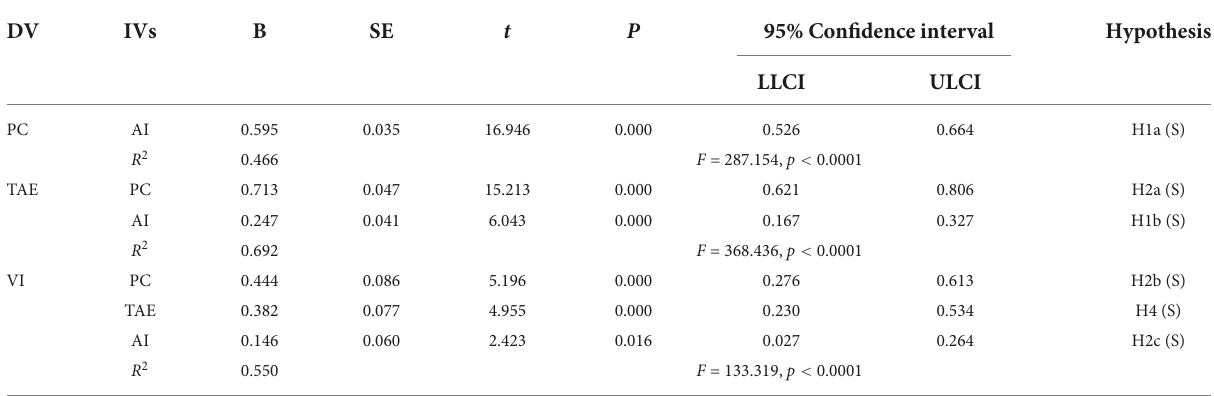
TABLE 3 Regressions analyses.